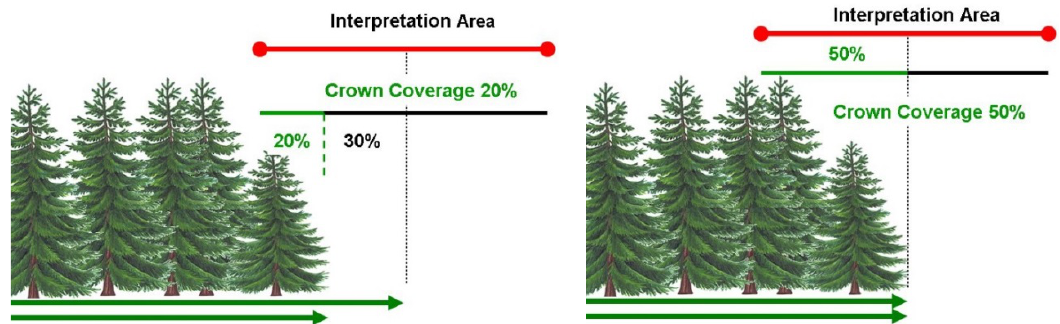
Figure 4. Problems related to the forest area at forest border within the interpretation area (red line) when its center (dashed line) is clearly outside the forest ( left ) and exactly at the forest border ( right ).